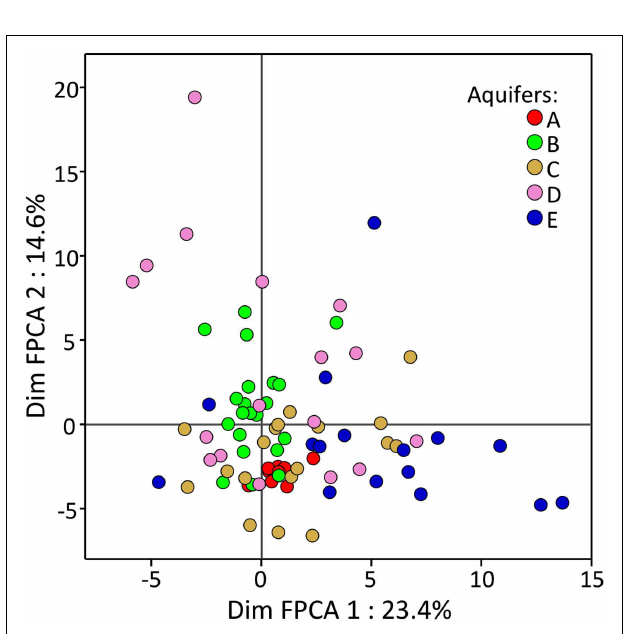
FIGURE 1 | Functional principal component analysis (axis 1 and 2) carried out onT-RFLP profiles generated from the bacterial communities present in 84 groundwater samples taken from five CE-contaminated aquifers. Different colors are used to display samples from the different aquifers. Axis coordinates were corrected for “ Methodology ”.